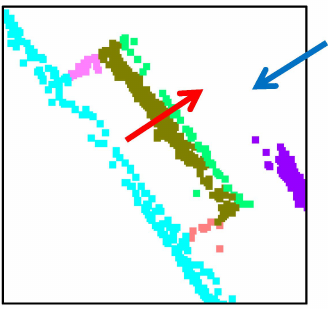
Figure 21. Enlarged area which is enclosed by the red dashed circles in Figure